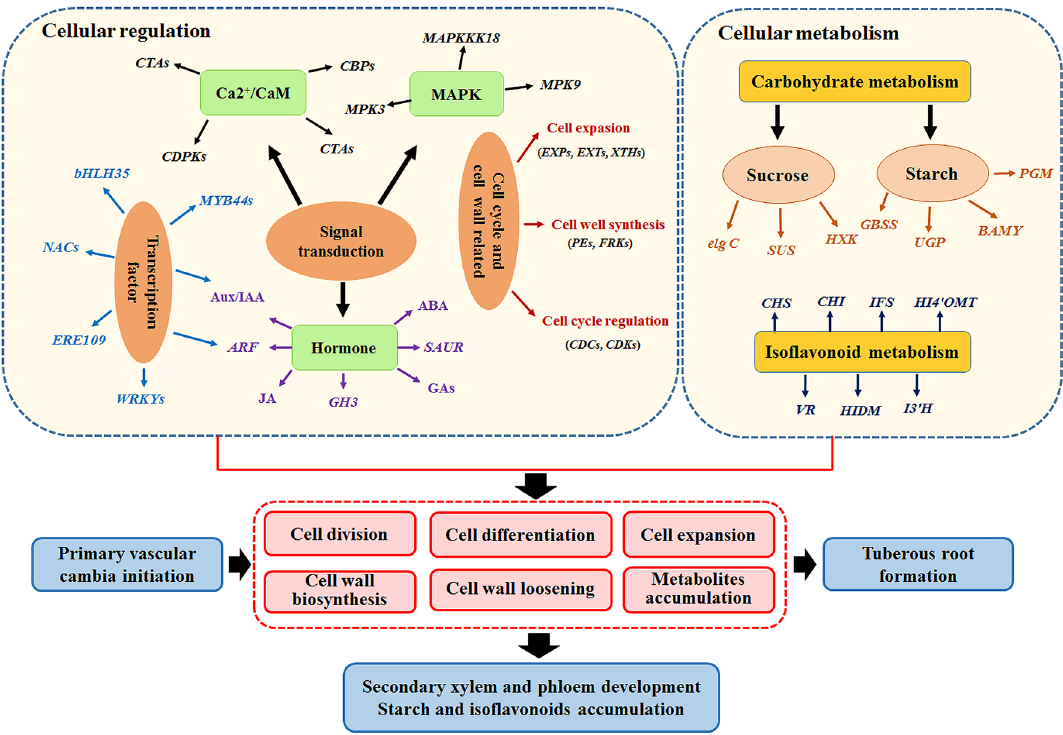
Figure 8. A proposed model of genetic regulatory mechanism during root thickening of C. speciosa